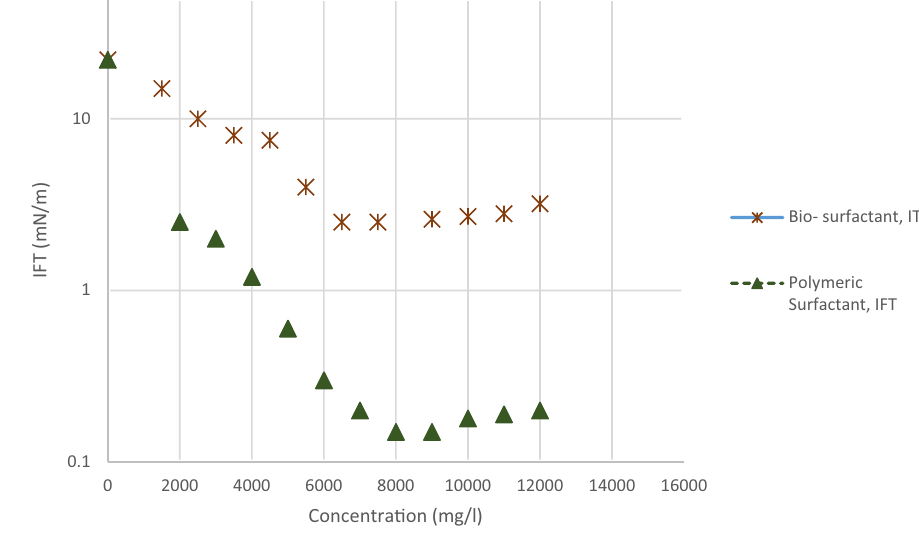
Fig. 8 Interfacial tension (IFT) study of surfactant and polymeric surfactant at various concentration . Temperature 28